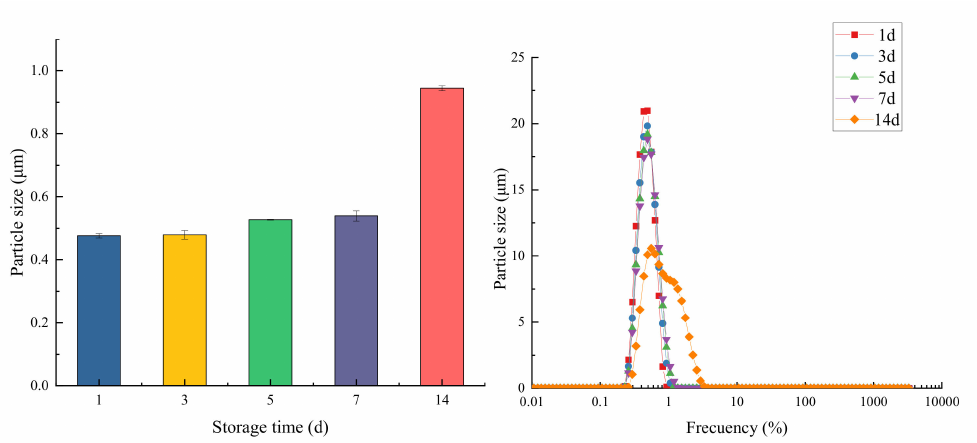
Figure 11. The change of emulsion particle size under different storage times ( left ) and its particle size distribution diagram ( right